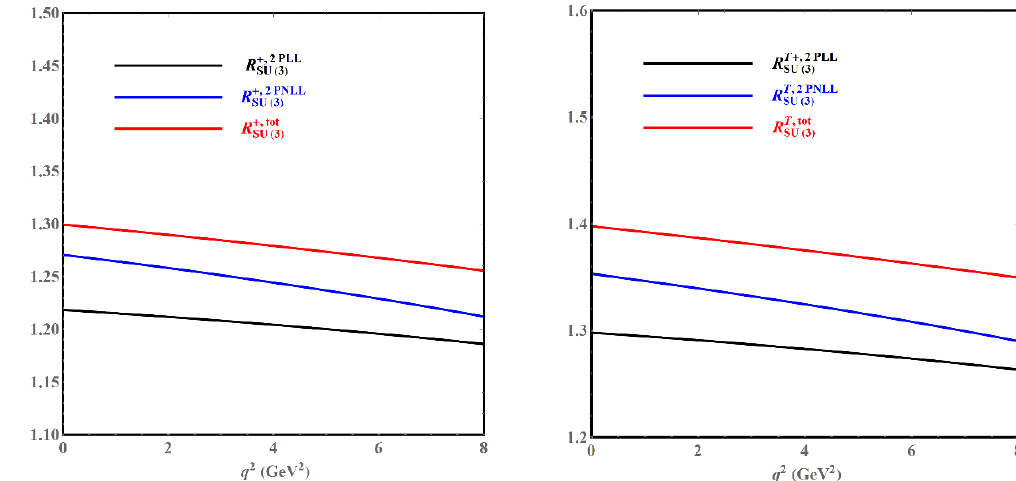
Figure 4 . The SU(3)-(cid:13)avour symmetry breaking e(cid:11)ects between B ! (cid:25) and B ! K form factors predicted from the LCSR with B -meson LCDAs. The momentum-transfer dependence of the ratio R 0 ( q 2 ) behaves in a similar way to R + ( q 2 ) at 0 (cid:20) q 2 (cid:20) 8 GeV 2 and we will therefore not SU(3) SU(3) display this ratio for